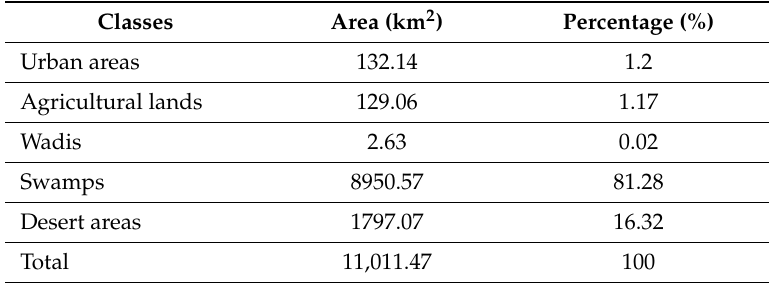
Table 13. Land cover analysis for Al-Shamal train pathway in Al-Qurayyat city in 2020.